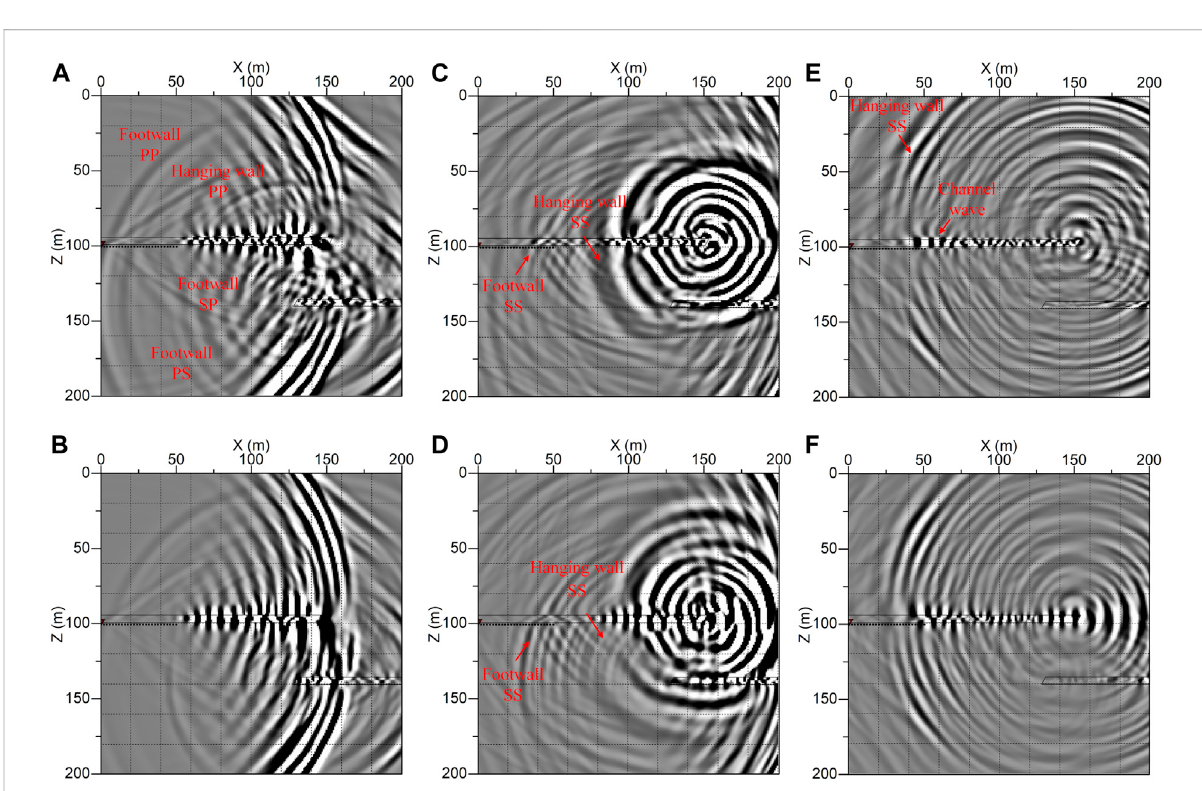
FIGURE 10 Snapshots of the advanced faulted coal seam model. (A) 75 ms X-component; (B) 75 ms Z-component; (C) 105 ms X-component; (D) 105 ms Z-component; (E) 150 ms X-component; (F) 150 ms Z-component.